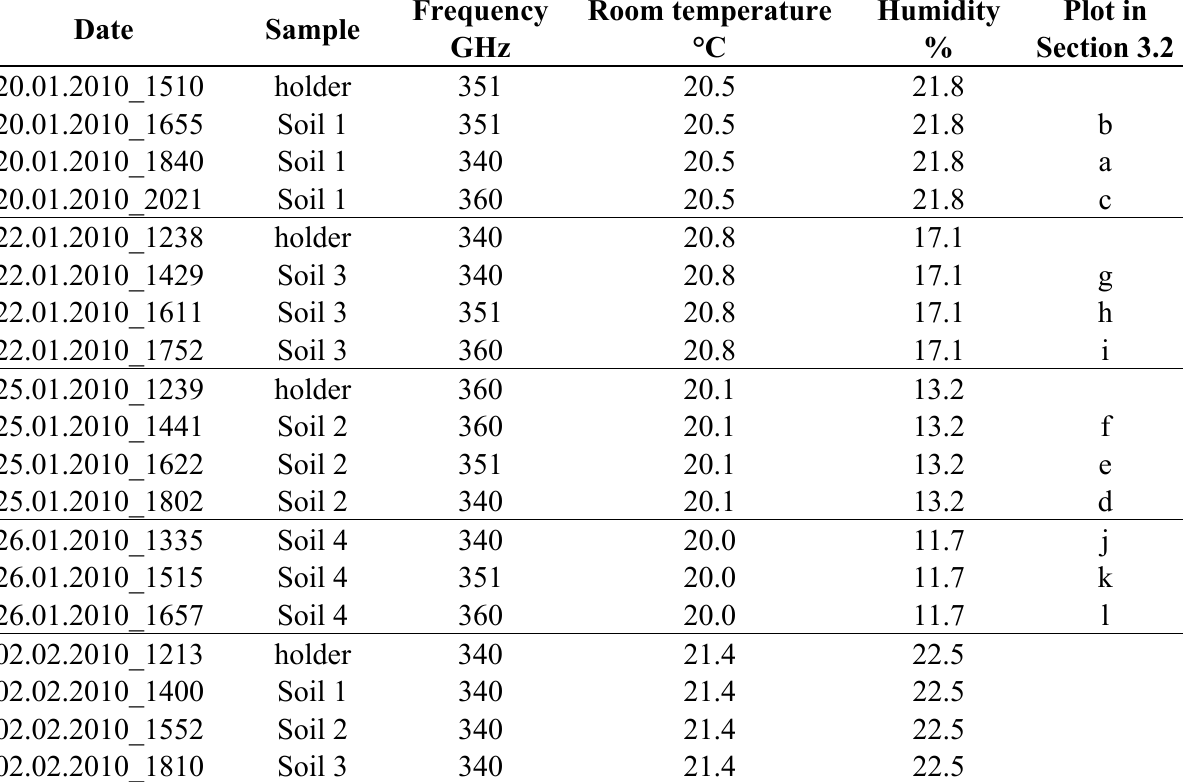
Table 3. Test procedure with the used measurement